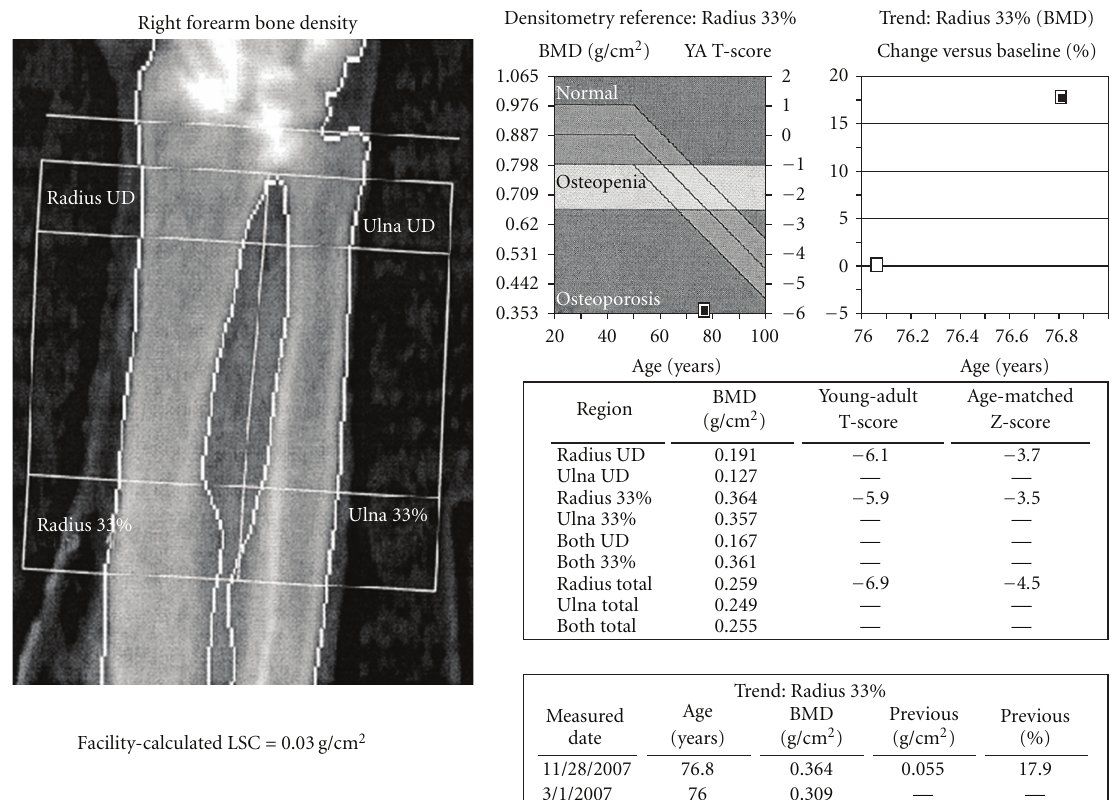
Figure 3: Bone remineralization following aggressive oral repletion with cholecalciferol and calcium